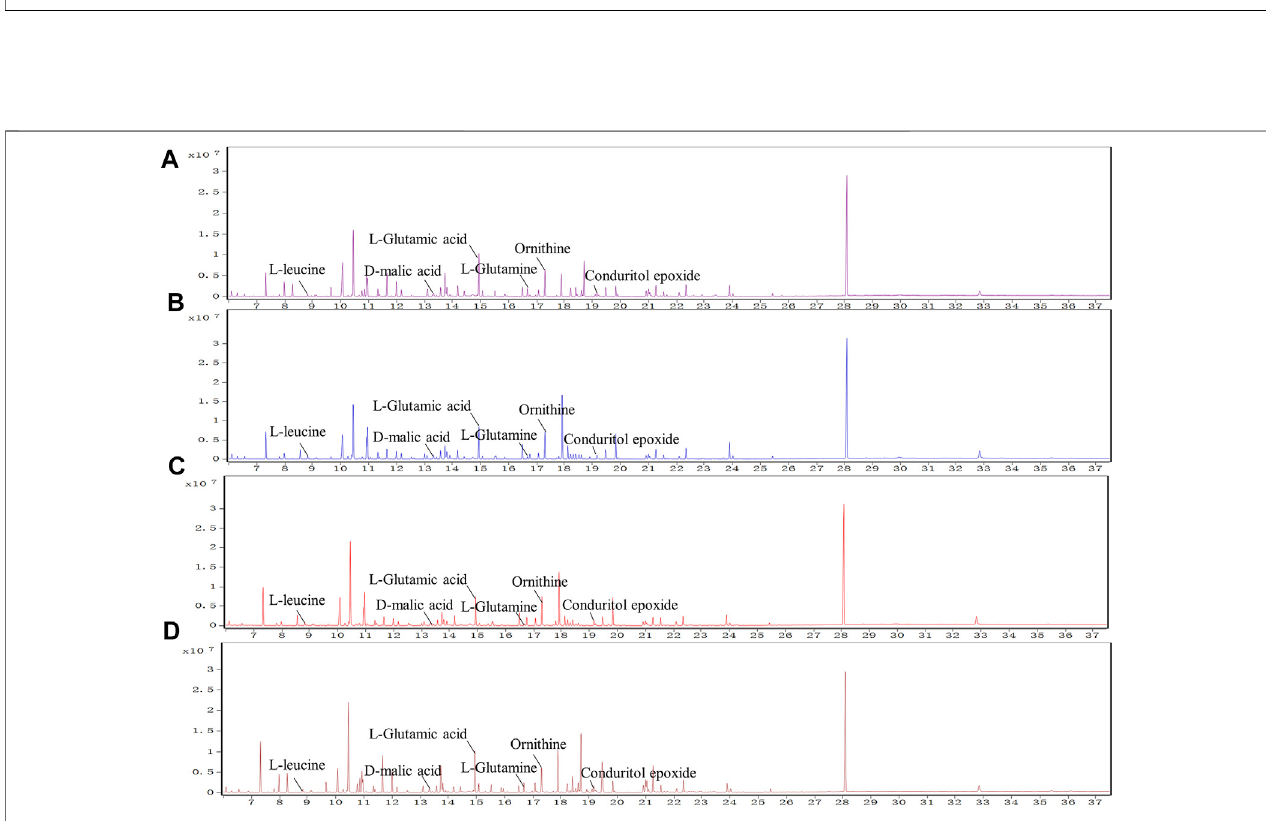
FIGURE 6 | TICs of metabolites from kidneys. (A) control group (B) benazepril group (C) QRKSG group (D) model group.